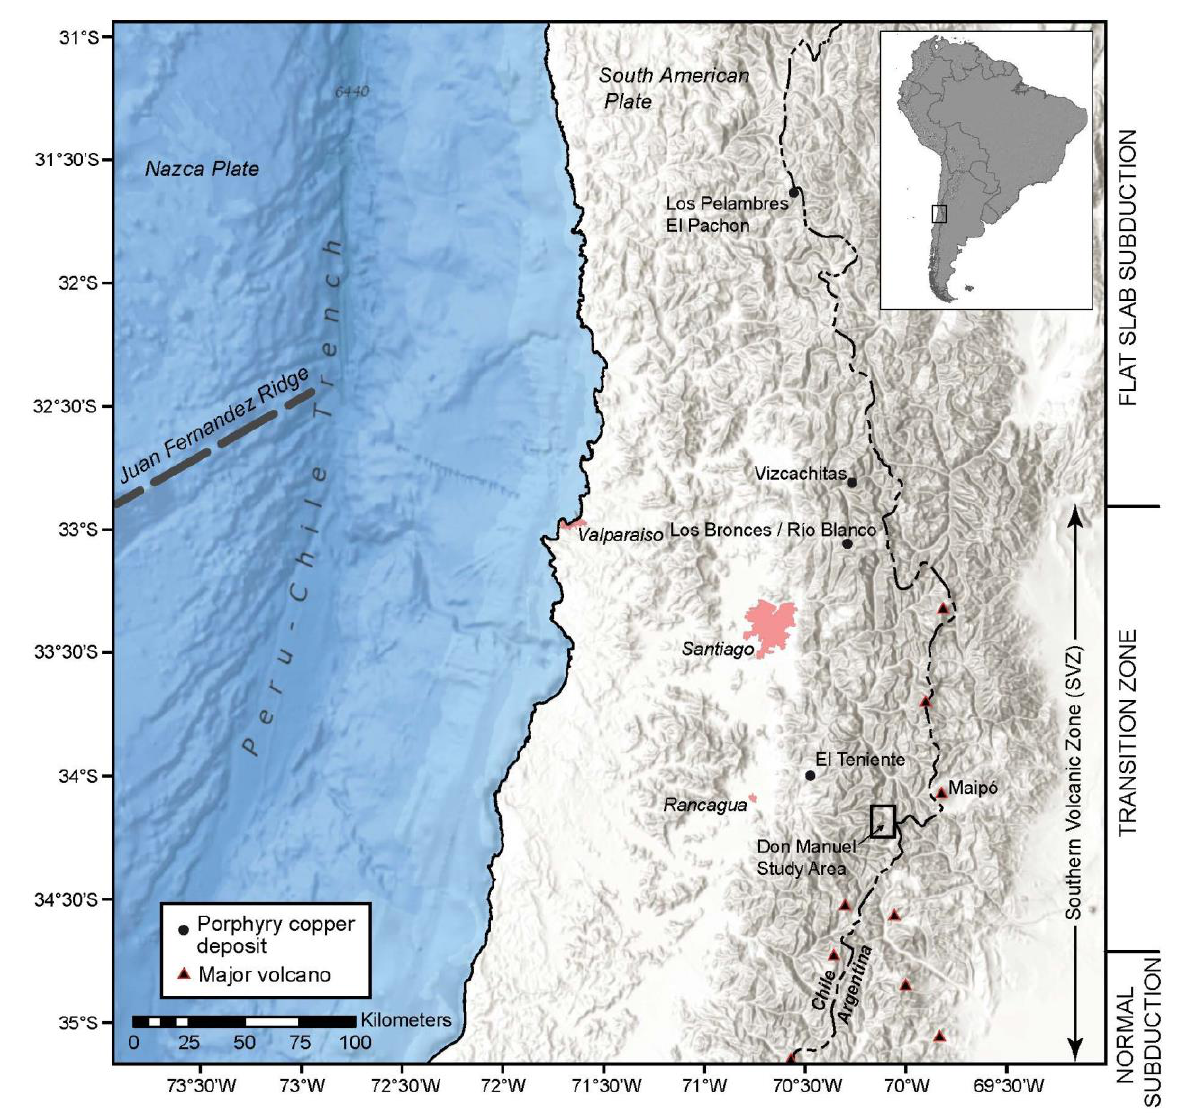
Figure 1. Location of the Don Manuel porphyry copper system, major volcanoes, and Miocene–Pliocene porphyry copper deposits (PCDs) in central Chile including El Teniente, Los Bronces-Río Blanco, Vizcachitas, and Los Pelambres.